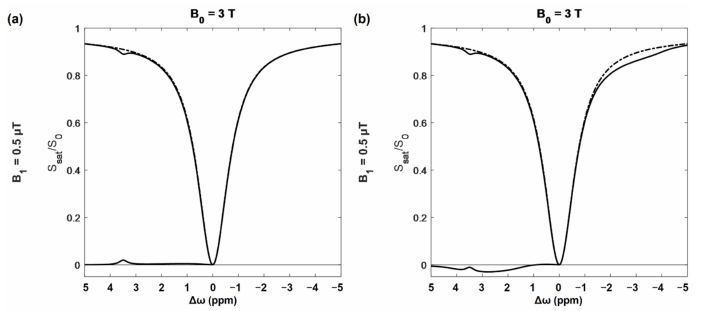
Figure 2. Simulated z-spectrum and MTR asymmetry (MTR asym ). Dashed line contains contributions from water and magnetization transfer (MT). Solid line contains additional contributions from amide, glutamate, guanidine, myo-inositol ( a , b ), as well as from nuclear Overhauser effect (NOE) ( b ). Corresponding MTR asym plots are located in the bottom left corner of both plots. Most of the CEST peaks are either too small, or too close to the water peak to be easily visible at 3T magnetic field (B 0 ), but the amide peak at 3.5 ppm is quite clearly seen here. B 1 —the amplitude of saturation radiofrequency pulse; S 0 —signal without saturation; S sat —signal with saturation; ∆ ω —frequency offset in reference to water